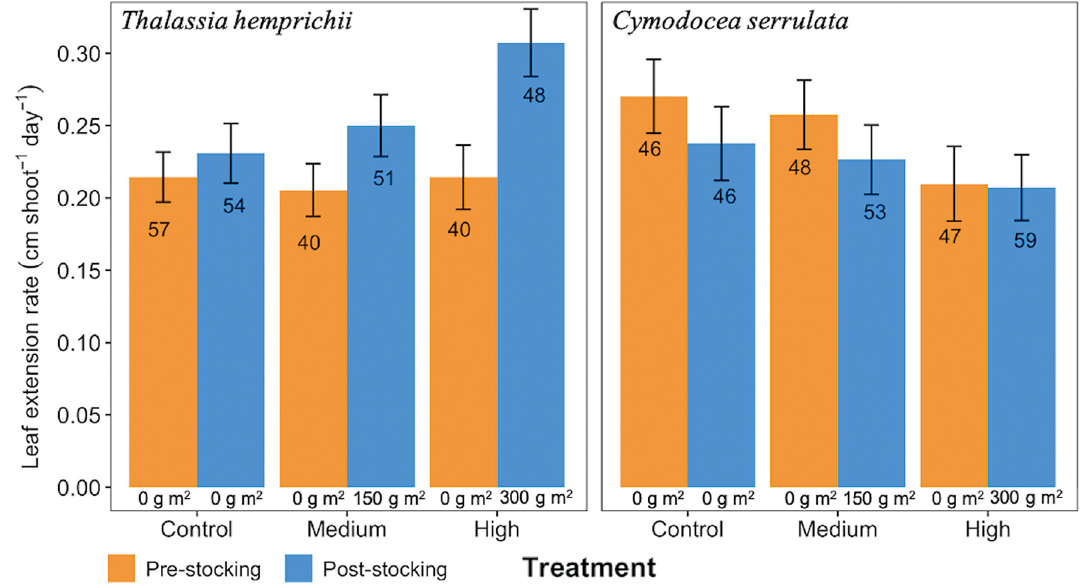
Fig. 3. Mean (±SE) seagrass leaf extension rates for the 2 most dominant seagrass species. Stocking densities (g Holothuria scabra m −2 ) used in the 3 treatments are shown below each bar for the 2 growing phases: pre-stocking and post-stocking. Each bar represents the mean growth rate of all individual seagrass blades from Sites A and B for Thalassia hemprichii and from Sites C and D for Cymodocea serrulata for each treatment (number of observations are shown underneath error